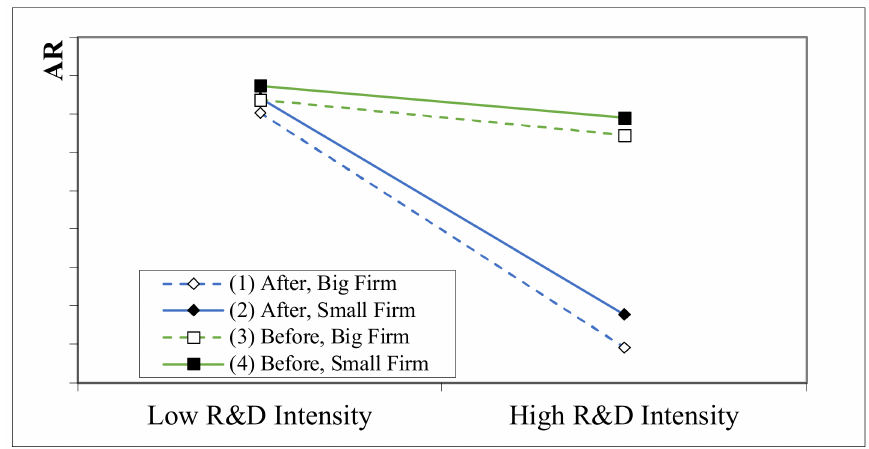
Figure 1. The moderating effect of firm